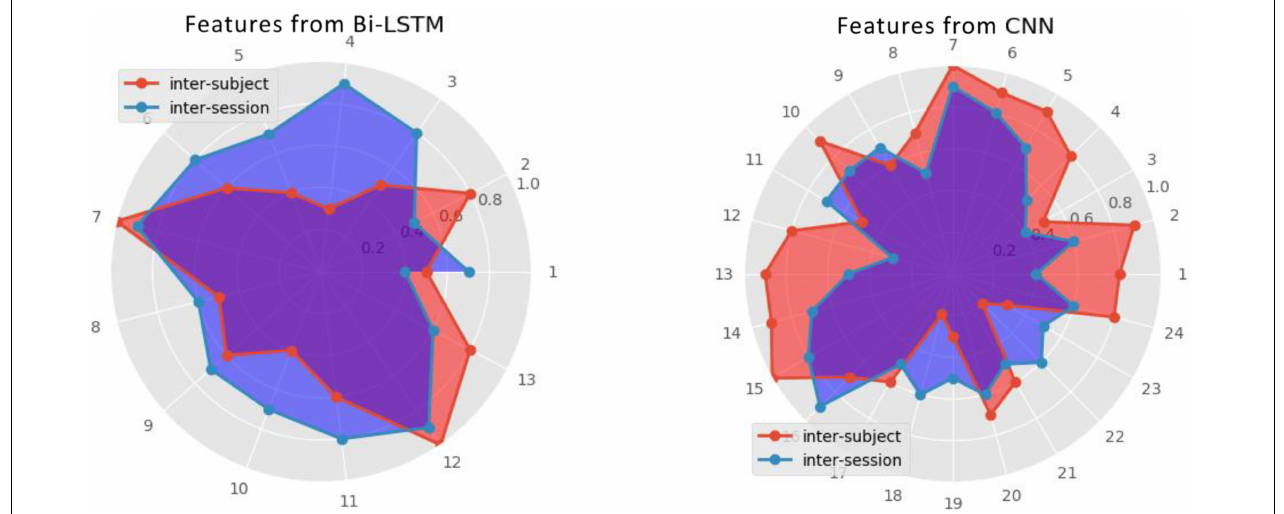
FIGURE 10 | The comparison of feature fusion in radar